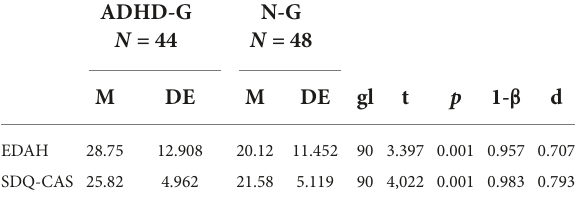
TABLE 3 Differences between groups for EDAH and SDQ-Cas—scales means ( N = 92). ADHD-G